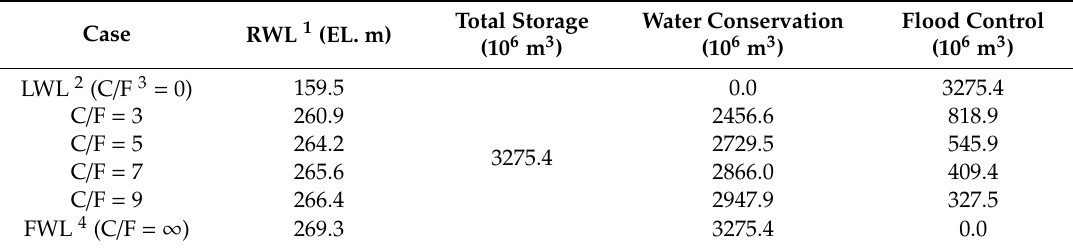
Table 2. Water conservation storage and flood control storage depending calculated by applying the assumed C / F